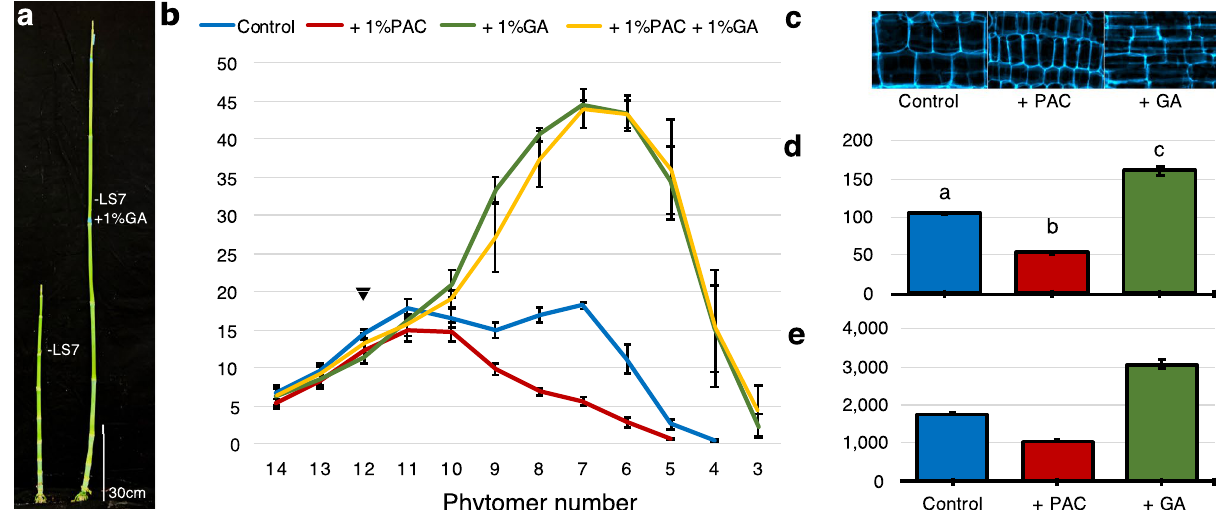
Figure 4. GA3 alters sorghum internode length, cell length and number. ( a ) Photograph of sorghum stems from control plants 14 days after removal of the leaf sheath (LS) from phytomer 7 (− LS) and plants treated with GA3 after LS removal (− LS, 1% GA3) (right). ( b ) Average length of internodes of control (blue line), and plants treated with 1% GA3 (green line), 1% PAC (red line) or both compounds (yellow line). Site of LS removal and GA3/PAC application is marked (solid inverted triangle). ( c ) Micrographs of longitudinal sections from the middle section of fully elongated internode from phytomer 7 (solid star) stained for cellulose. ( d ) Average length of cells and ( e ) average number of cells spanning the length of internode 7 following 14 days of treatment. One-way ANOVA, followed by Tukey comparison test, indicated significant differences between control, + PAC and + GA conditions with P < 0.0001 (n = 291). Different letters indicate significance. Error bars: highly expressed in young leaves 69 and in maize, ZmGA3ox2 is expressed at low and varying levels in several organs and tissues 71 . SbGA3ox2 was expressed at relatively low levels in tissues of the sorghum transcriptome compendium except dry and germinating seeds where expression was elevated (see Supplementary Table S3). The sorghum transcriptome compendium contains RNA from vegetative and reproductive tissues, but the compendium does not contain RNA-seq profiles comparing shaded to non-shaded plants. Therefore, qRT-PCR was used to conduct a systematic analysis of SbGA3ox2 expression in the shoot apex, leaf blade (LB), leaf sheath (LS), and stem tissues that comprise phytomer 3 (prior to internode elongation) through phytomer 8 (fully elon- gated internodes) of vegetative plants grown at high and low planting density. Leaf tissue samples were collected from the mid-point of the leaf blade (LB center), the growing zone located at the base of the leaf blade (LB base), and the LB:LS collar tissue (see Supplementary Fig. S4). Tissues were also collected from the middle of the leaf sheath (LS center), leaf sheath base growing zone (LS base), LS: stem collar tissue (LS collar) (see Supplementary Fig. S4). Stem tissues collected included the nodal plexus, a stem nodal tissue where the leaf sheath joins the stem, internodes, and the pulvinus, a tissue located between the internode growing zone and the nodal plane 73 (see Supplementary Fig. S4). Relative expression of SbGA3ox2 in these tissues was quantified using qRT-PCR (Fig. 5). At 0.15 m spacing (high planting density), SbGA3ox2 expression was highest in the LB base and/or LB:LS collar of each phytomer, followed by tissues in the middle of the leaf blade (Fig. 5a, LB center). SbGA3ox2 expression in the LB:LS collar was higher in phytomers 3–5 that contain elongating internodes compared to phytomers 7–8